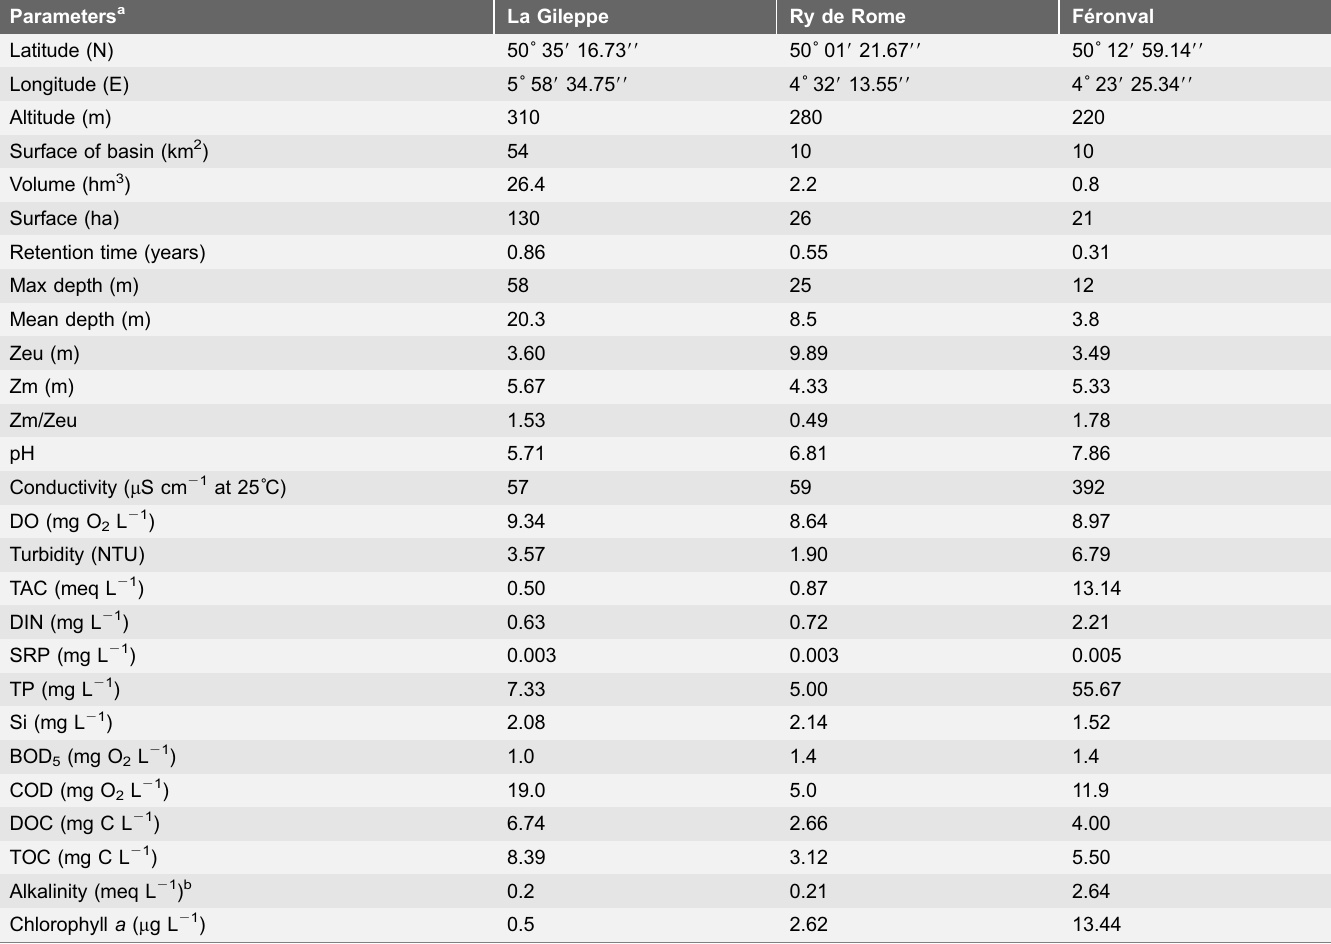
Table 1. General characteristics of the three analysed reservoirs and annual average values of some physical and chemical parameters. Parameters a